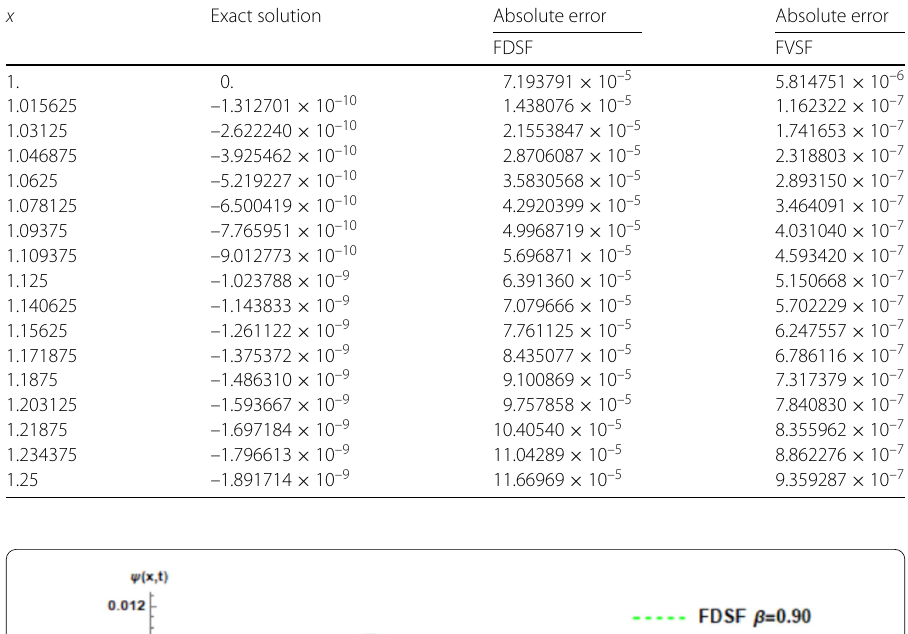
Table 2 Exact solution and absolute errors for Example 1 at time t = 1, β = 1, fixed h = 0.015625 and τ = 0.01 using FDSF and FVSF